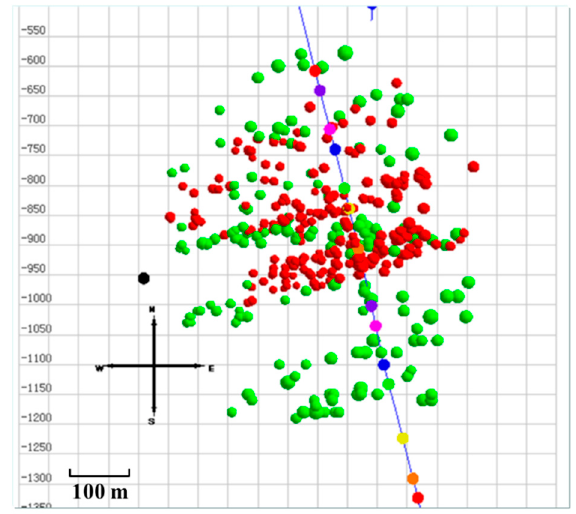
Figure 11. Micro seismic monitoring results after repeated fracturing.